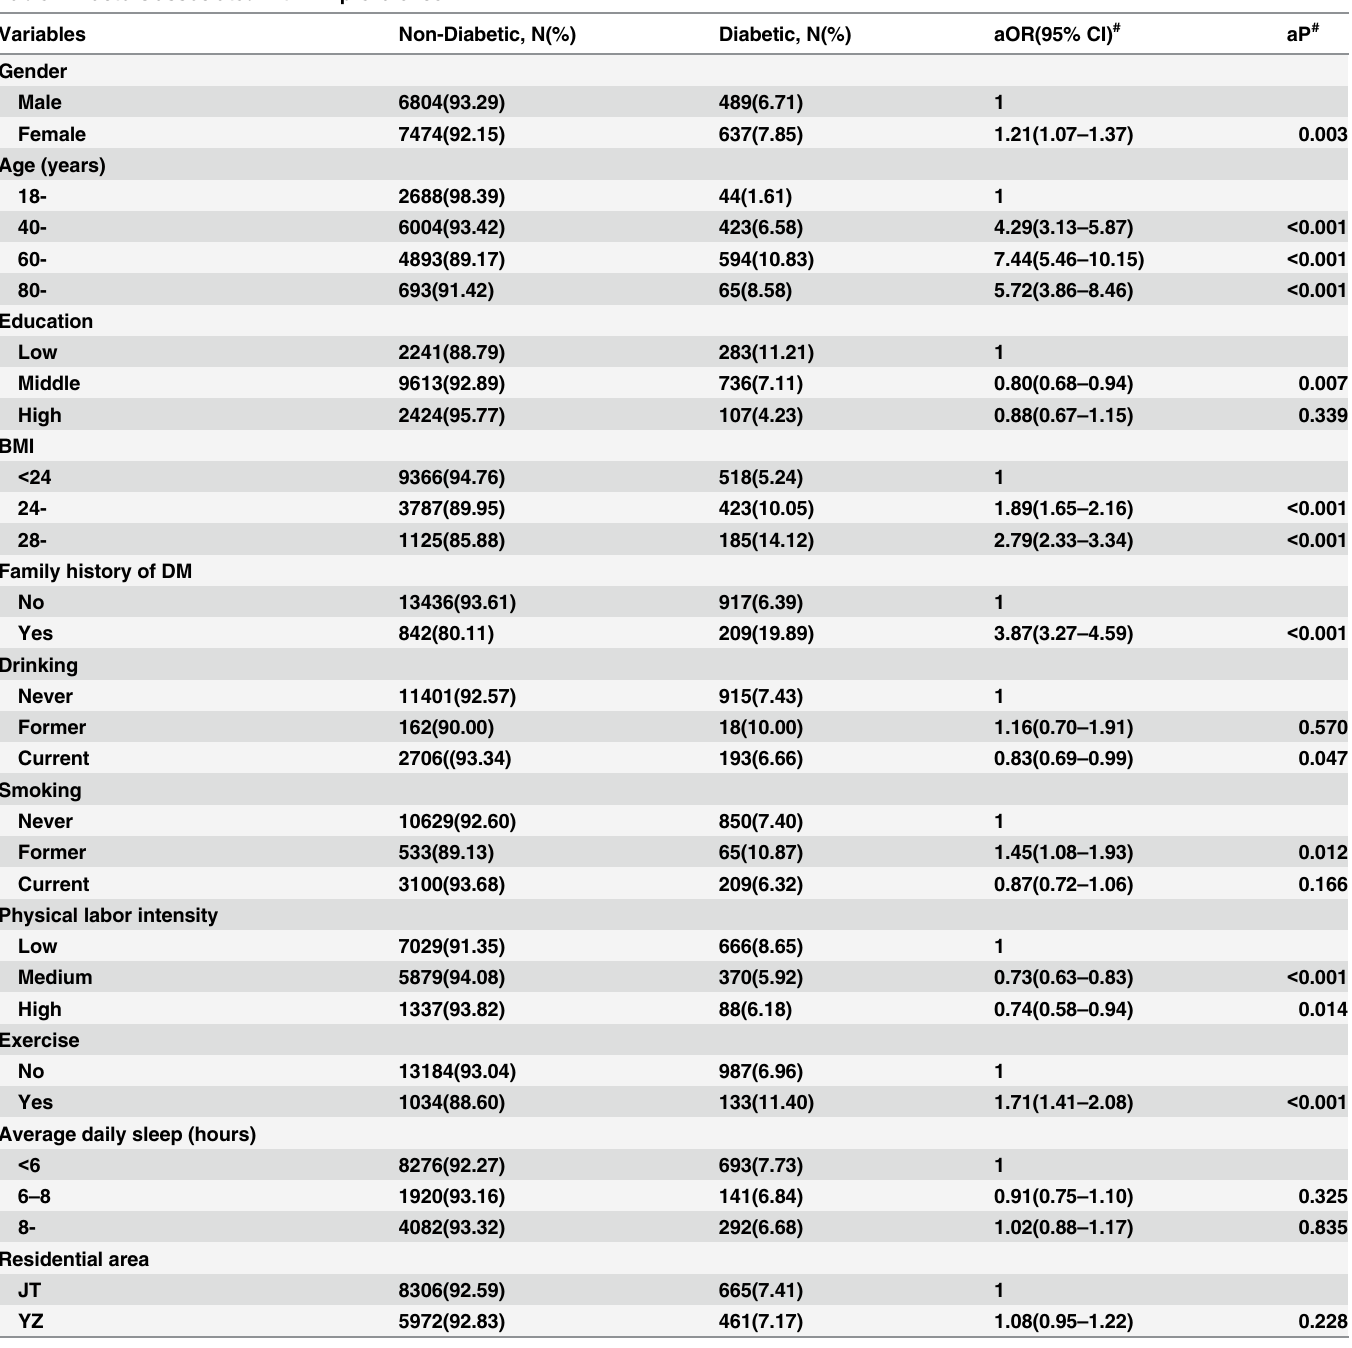
Table 2. Factors associated with DM